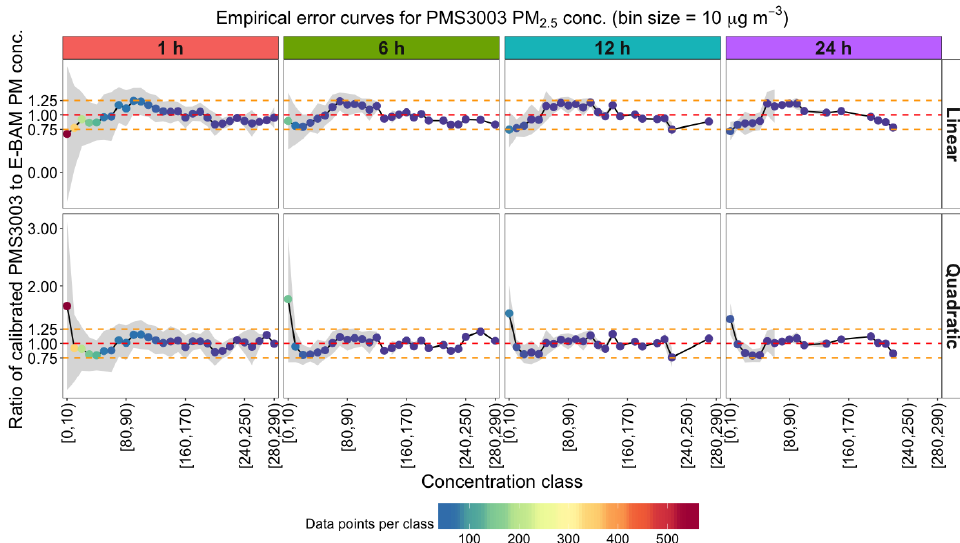
Figure 12. Empirical error curves for the E-BAM calibrated Plantower PMS3003 PM 2 . 5 measurements at 1, 6, 12, and 24h time intervals from two different calibration methods (i.e., simple linear and quadratic equations). The curves were generated from the combination of the Duke University and IIT Kanpur data sets. The points and lines represent the means of ratios of E-BAM-calibrated PMS3003 to E- BAM PM 2 . 5 measurements in different concentration classes, each of which spans a 10µgm − 3 interval. The shaded region represents the corresponding magnitudes of errors of PMS3003 PM 2 . 5 measurements after the E-BAM calibration. The concentration classes are color coded by the number of data points in each class. Note the shaded region is generally absent from near the upper end of the PM 2 . 5 ranges due to insufficient observations for the error evaluation. The red dashed line indicates a ratio of 1, while the two orange dashed lines indicate ratios of 0.75 and 1.25,